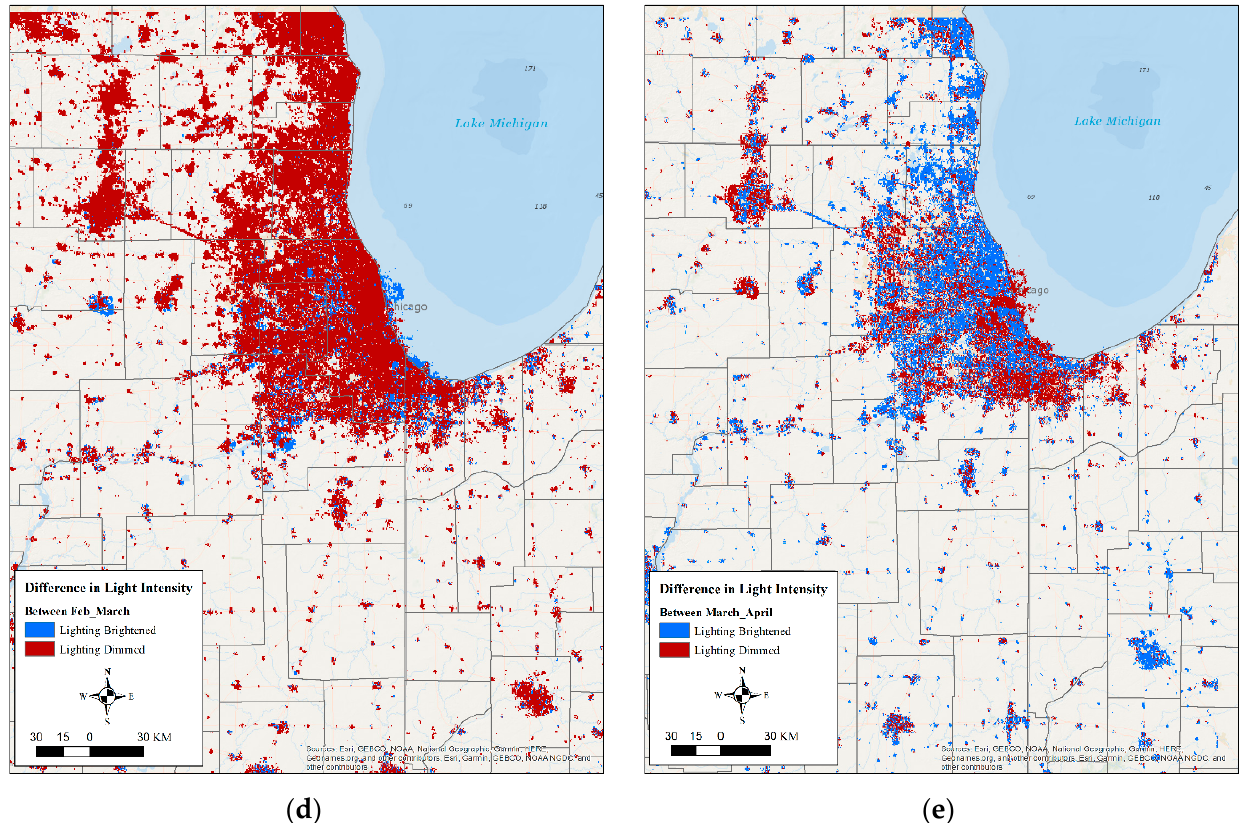
Figure 19. Nighttime light (NTL) intensity distribution from VIIRS for Chicago in February ( a ), March ( b ), April ( c ); change in NTL intensity in Chicago between February and March ( d ) and between March and April ( e ).